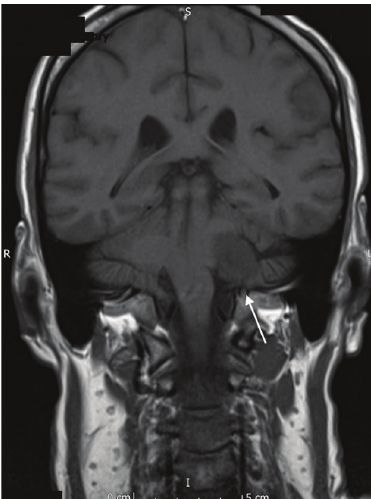
Figure 1: Coronal MR image (T1 weighted) showing the vestibular schwannoma affecting the left vestibulocochlear nerve.